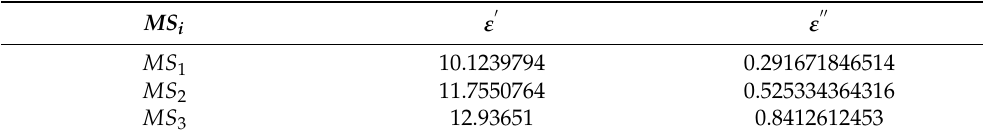
Table 5. The values of ε (cid:48) and ε (cid:48)(cid:48) for the MSs. MS